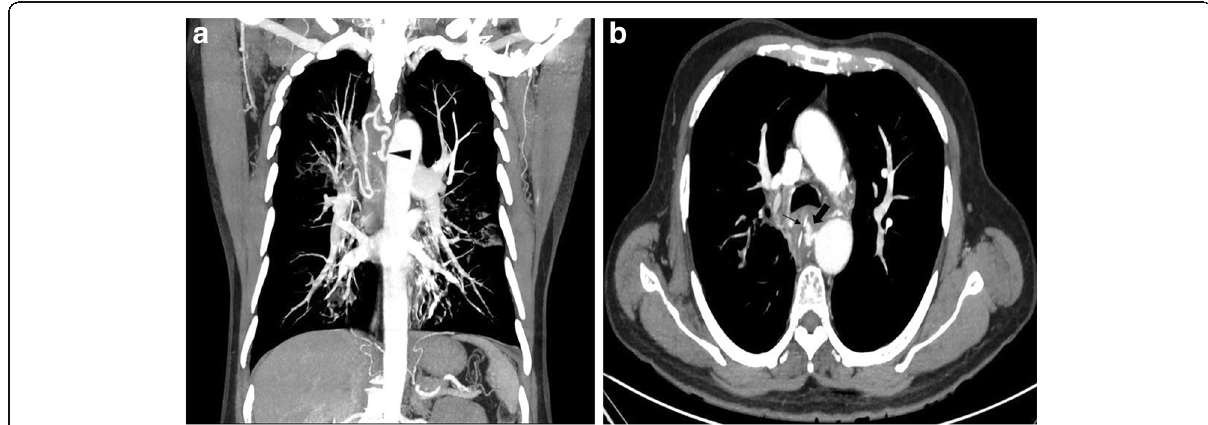
Fig. 3 a , b Post contrast 3D multiplanar reformatted (3D-MPR) coronal ( a ) and axial ( b ) CT images show a hypertrophied right bronchial artery (arrowhead) and a bronchial artery pseudoaneurysm (thick arrow) in intimate contact with the fish bone (thin